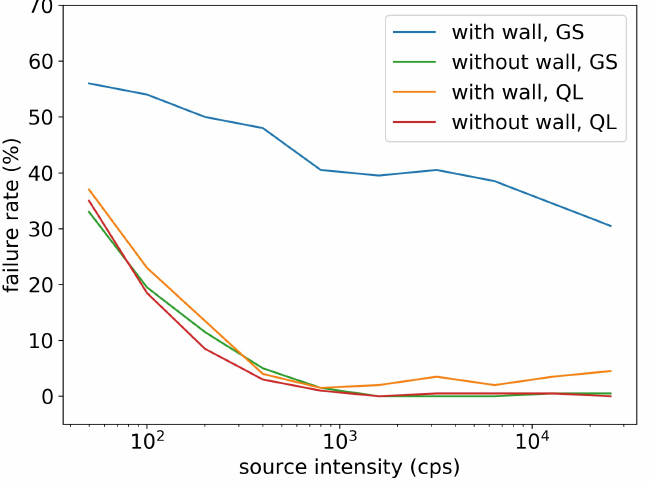
Figure 9. Failure rate of the Q-learning algorithm (QL) and the gradient search algorithm (GS) in the radiation source searching test, for simulation areas with walls and without walls. Without walls, the two algorithms had the same failure rate; with walls, the Q-learning algorithm achieved much smaller failure rate than the gradient search